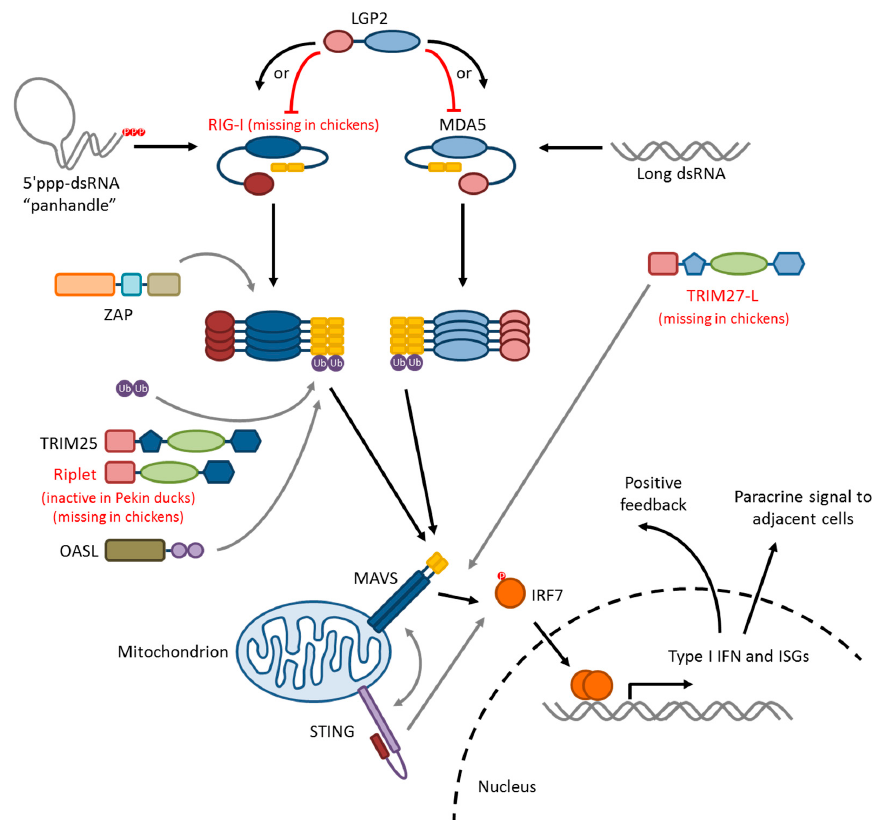
Figure 2. Duck RIG-I-like receptor (RLR) family signaling pathway. The duck RLR family consists of three cytoplasmic receptors: RIG-I, MDA5, and LGP2. RIG-I and MDA5 detect viral RNA species and initiate interferon signaling. LGP2 does not possess a signaling domain and may act as a positive or negative regulator of the other two. RIG-I recognizes 5’-triphosphorylated RNA “panhandle” structures formed by the complementary ends of each influenza genome segment. MDA5 recognizes long double-stranded RNA. Ligand recognition leads to oligomerization of the receptors and releases the N-terminal caspase activation and recruitment domains (CARD) domains (shown as yellow rectangles) from repression by the C-terminal regulatory domain. Cytoplasmic zinc-finger antiviral protein (ZAP) protein may interact directly with RIG-I to stabilize RNA-bound tetramers. Short K-63-linked polyubiquitin chains synthesized by tripartite motif-containing protein 25 (TRIM25) stabilize the RIG-I CARD domain oligomers, which interact with similar CARD domains on mitochondrial MAVS. Duck Riplet appears to be missing its catalytic domain and likely cannot synthesize polyubiquitin chains. 2’-5’-oligoadenylate synthase-like protein (OASL) may stabilize RIG-I CARD domain oligomers with its own C-terminal ubiquitin-like domains in the absence of TRIM25-mediated ubiquitination. Activation of MAVS proteins leads them to multimerize in turn, and to serve as an assembly platform for a kinase cascade, which terminates in the phosphorylation of the transcription factor IRF7. A unique duck TRIM gene, TRIM27-L, promotes RIG-I signaling through an undefined interaction downstream of MAVS. Phosphorylated IRF7 dimerizes and is translocated to the nucleus where it initiates transcription of type I and type III interferon and interferon-stimulated genes. The expressed interferon is secreted to induce an antiviral state in the neighbouring cells and can also amplify RLR signaling in a positive feedback loop, since the pathway components are themselves interferon-inducible. RIG-I signaling activates stimulator of interferon gene (STING), an adaptor protein involved in sensing DNA viruses, which cross-talks with the RIG-I pathway. STING activation, in turn, prolongs the type I IFN response.